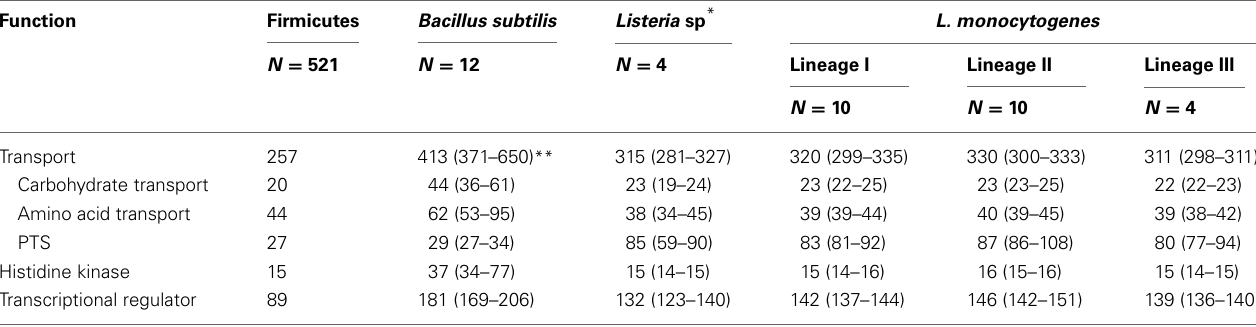
Table 4 | Median number of genes from functional categories transport, histidine kinase and transcriptional regulator across the genus Listeria compared to Bacillus subtilis and